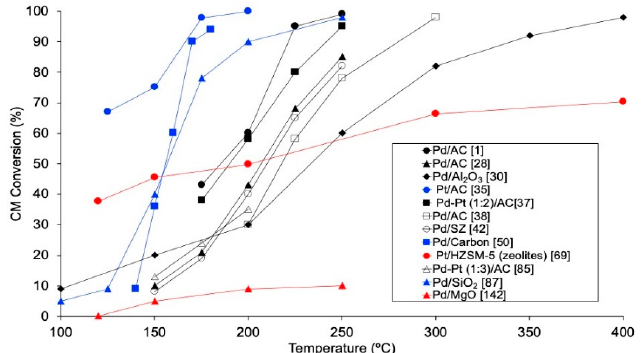
Figure 3. Evolution of the conversion of chloromethanes with temperature in the HDC of DCM (black), TCM (blue) and TTCM (red) in the literature.